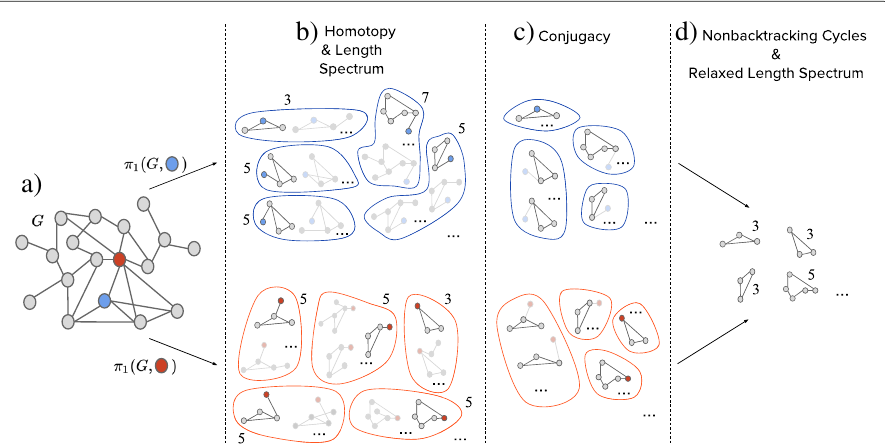
Fig. 3 Aggregating the values of the length spectrum. a A graph G with two nodes highlighted in red and blue. These two nodes are used as basepoints to construct two versions of the fundamental group: π 1 . b The set of all cycles based at the red node (left) and blue node (right). For either set of cycles, we encircle together those that are homotopy equivalent, thus forming a homotopy class. We annotate each class with its length, and we highlight the representative with minimal length. Note that the lengths of corresponding cycles (those that share all nodes except for the basepoints) can change when the basepoints change. c We have kept only the highlighted representative in each class in b) and encircled together those that are conjugate. In each conjugacy class, we highlight the (part of) each cycle that corresponds to the free homotopy loop. d By taking one representative of each conjugacy class, and ignoring basepoints, we arrive at the free homotopy classes, or equivalently, at the set of non-backtracking cycles. We annotate each cycle with its length. We arrive at the same set regardless of the basepoint. The ellipses inside the closed curves mean that there are infinitely many more elements in each set. The ellipses outside the curves mean that there are infinitely many more classes or